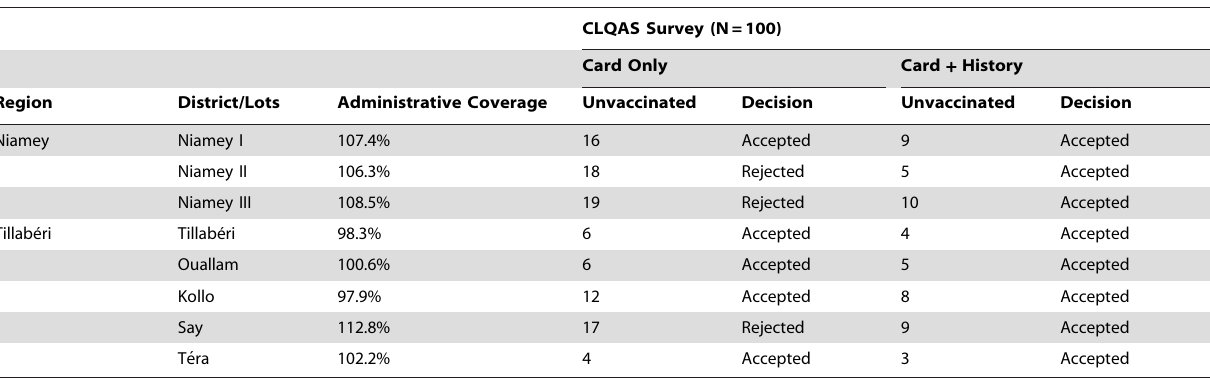
Table 4. Vaccination coverage results in persons aged 1–29 years for the second phase of the MenAfriVac introduction by administrative methods and Clustered Lot Quality Assurance Sampling (CLQAS) survey, Niamey and Tillabe´ri, Niger, December